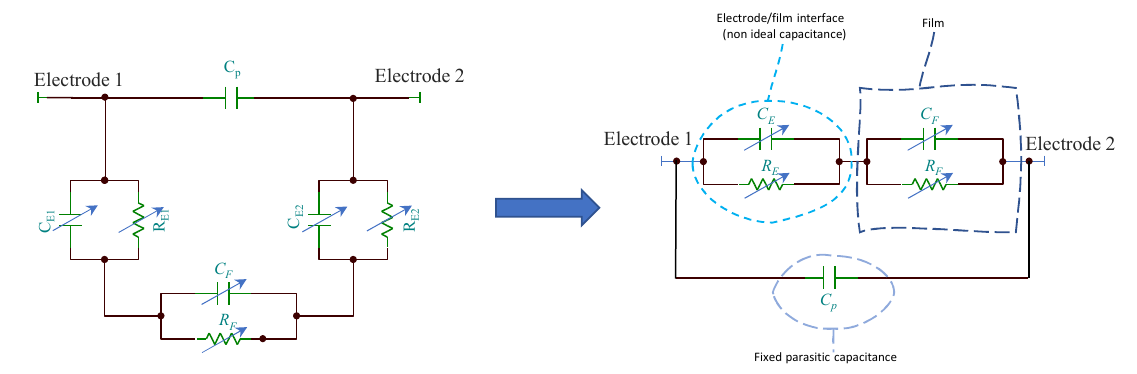
Figure 5. Equivalent circuits for the TiO 2 film in humid environment.